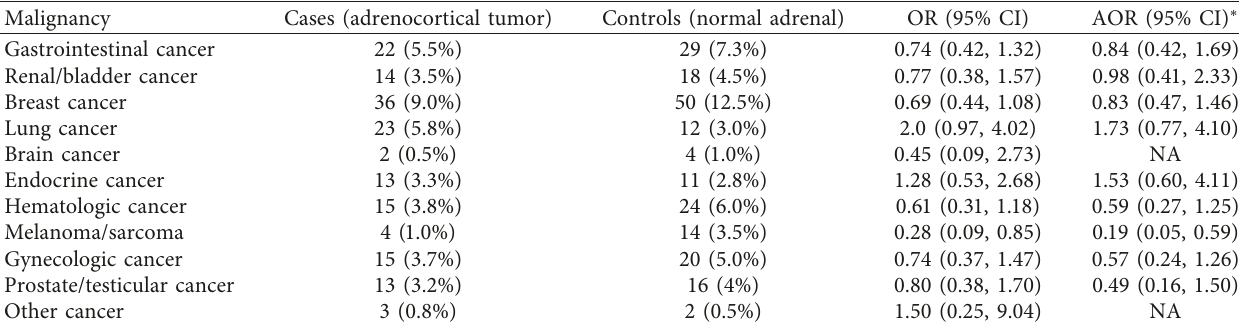
Table 6: Risk for malignant